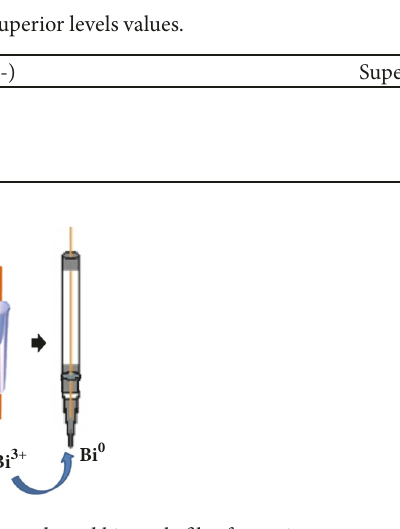
Figure 1: The assembly of pencil-lead graphite working electrode and bismuth-film